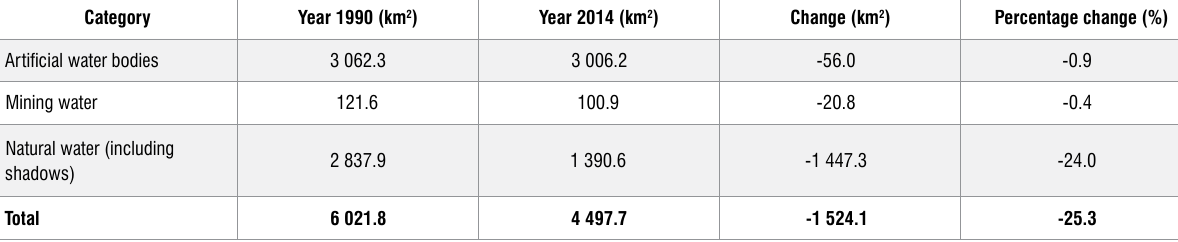
Changes in the spatial extent of surface aquatic ecosystems between 1990 and 2014